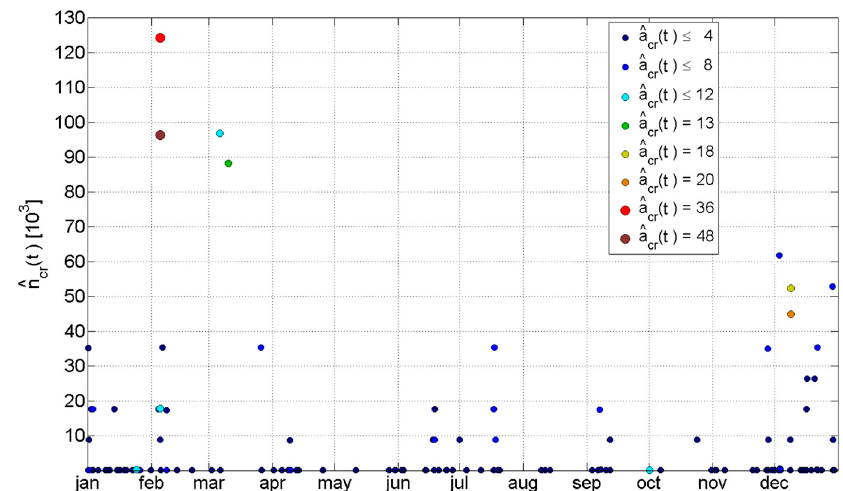
Figure 8. Individuation of the most critical hours in the N − 1 analysis.